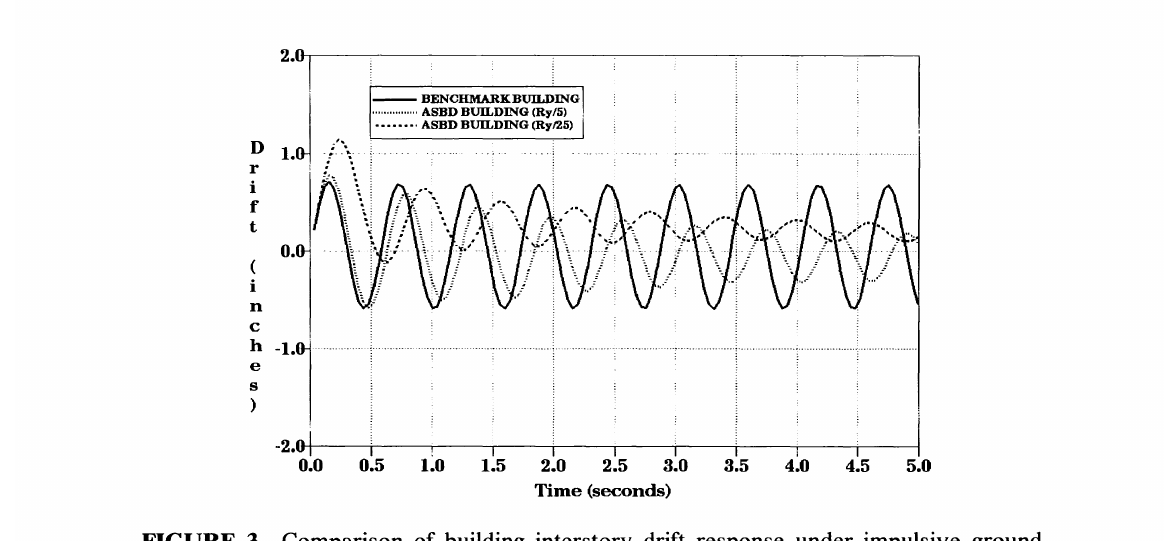
FIGURE 3 Comparison of building interstory drift response under impulsive ground